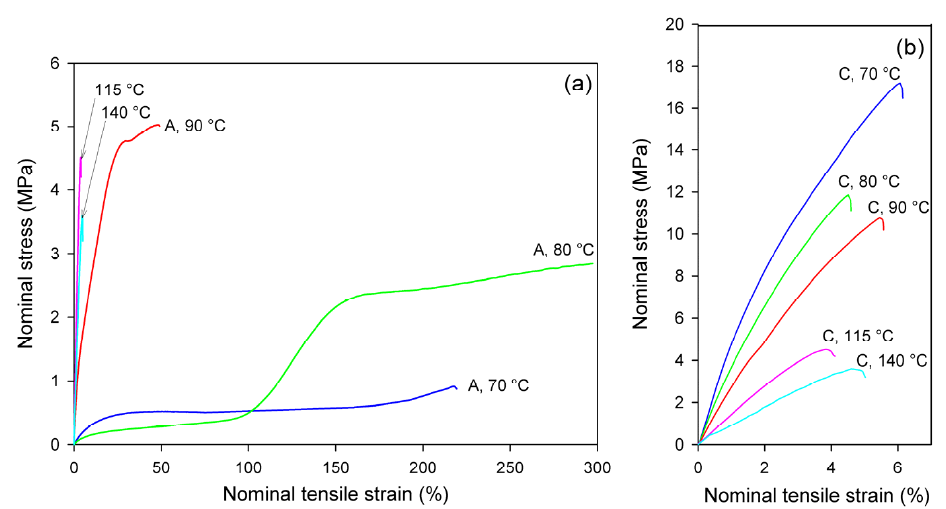
Figure 4. Nominal stress–nominal strain curves obtained in uniaxial tensile tests at temperatures indicated. ( a ) amorphous samples, A; ( b ) cold crystallized samples, CC. Note the different scale on the stress and strain axes in ( a , b ).